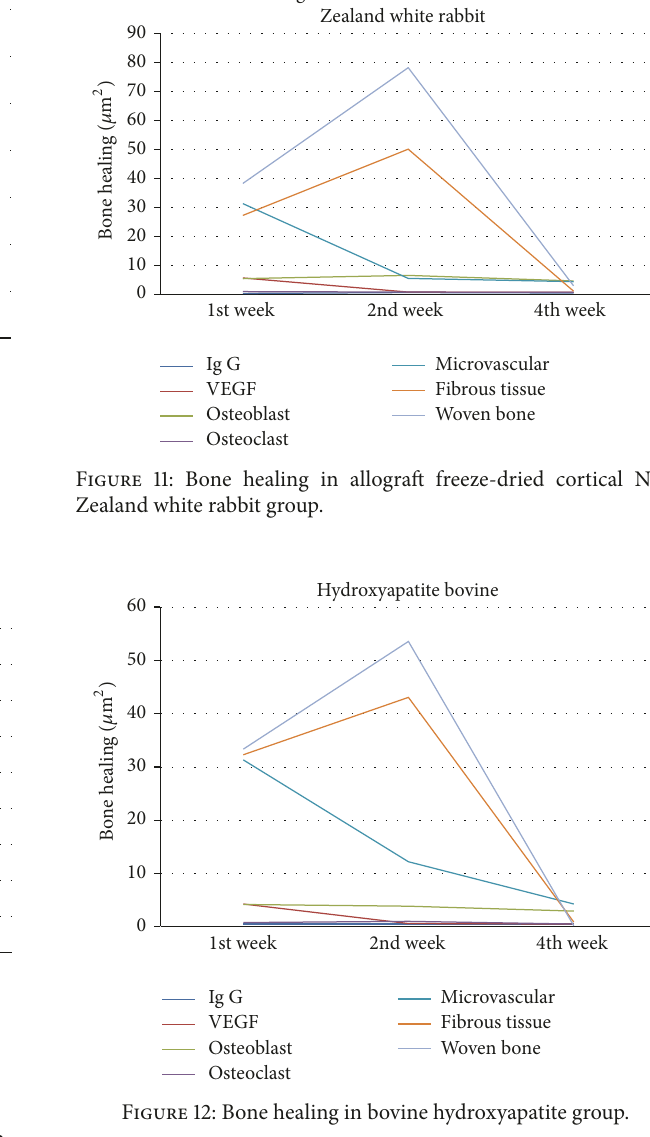
Figure 10: Bone healing in freeze-dried cortical bovine group.